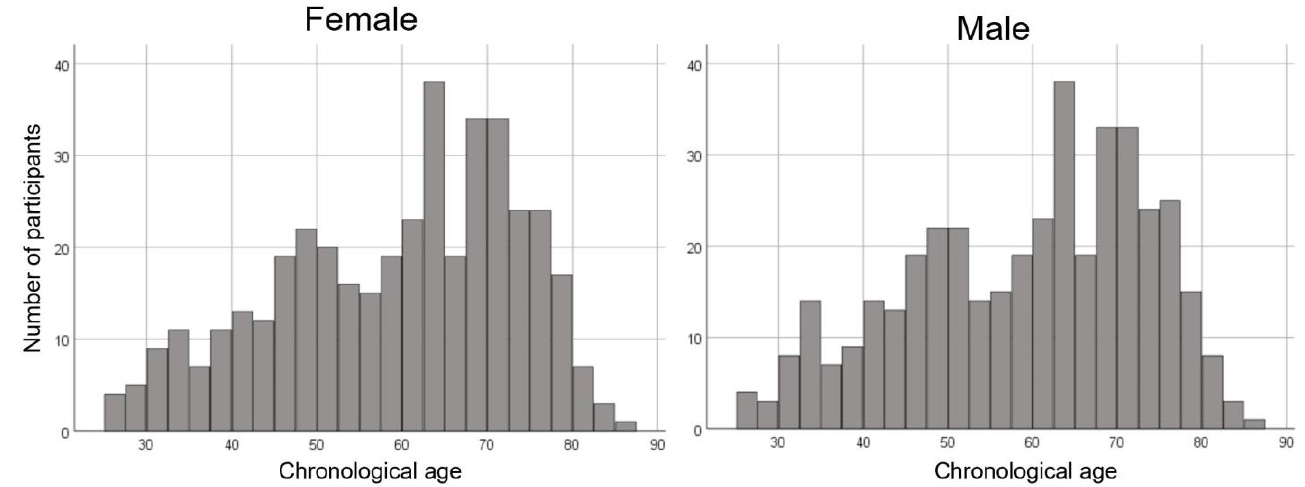
Figure 1. Histogram showing the age distribution for females and males in this study. 104